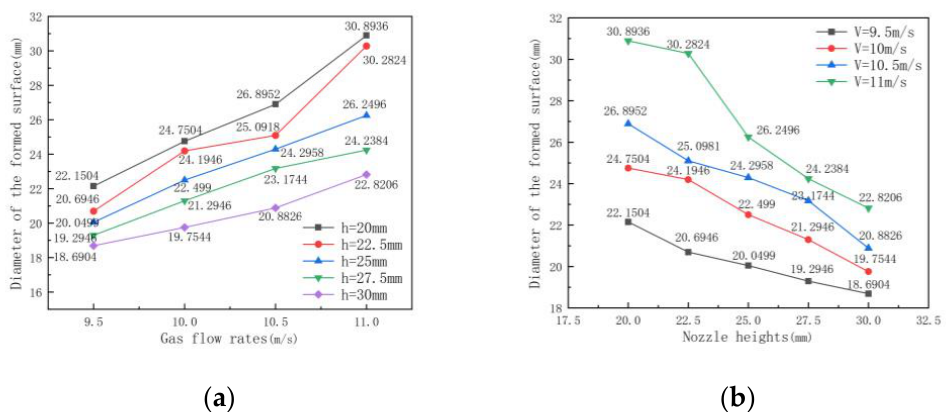
Figure 8. The diameter of the formed surface with different gas flow rates and nozzle heights in simulations. ( a ) is the relationship between the gas flow rate and the diameter of the forming surface. ( b ) is the relationship between the nozzle height and the diameter of the formed surface.